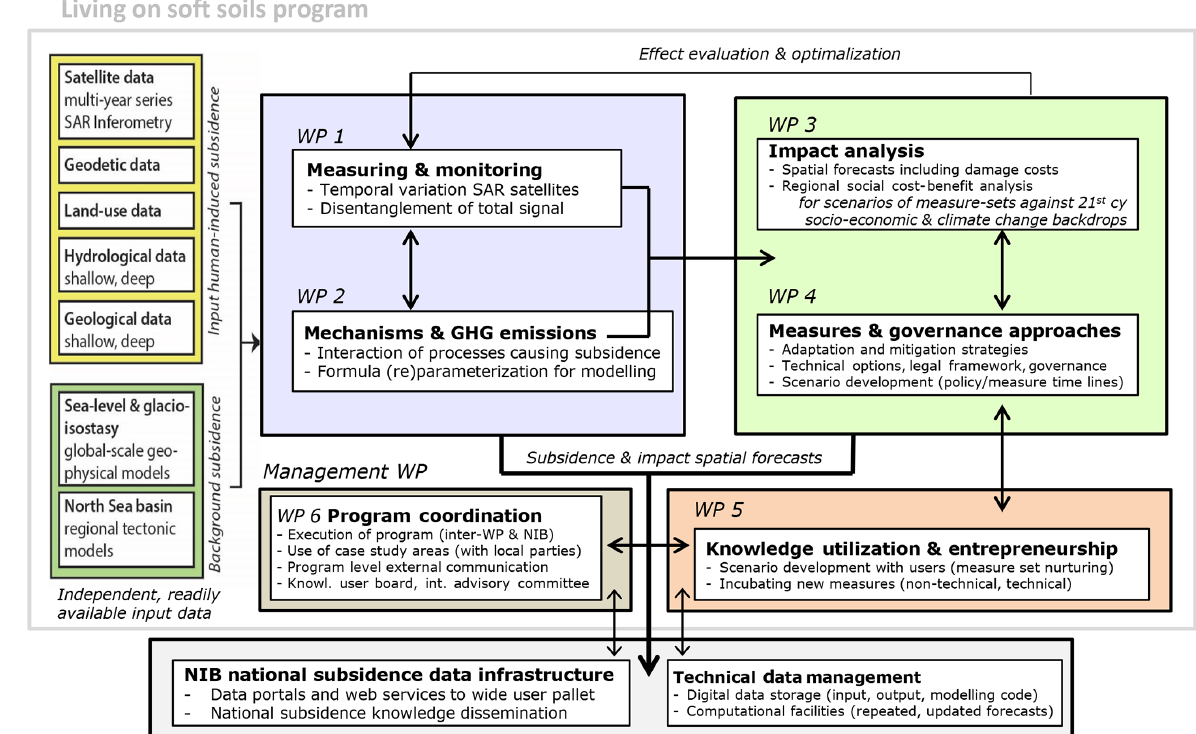
Figure 3. Program structure. We will follow an iterative approach whereby insights from the different work packages feed into one another and enrich the knowledge needs addressed by other